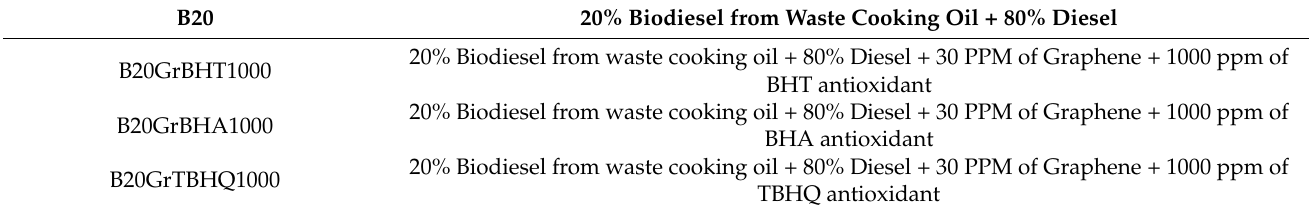
Table 4. Fuel blends